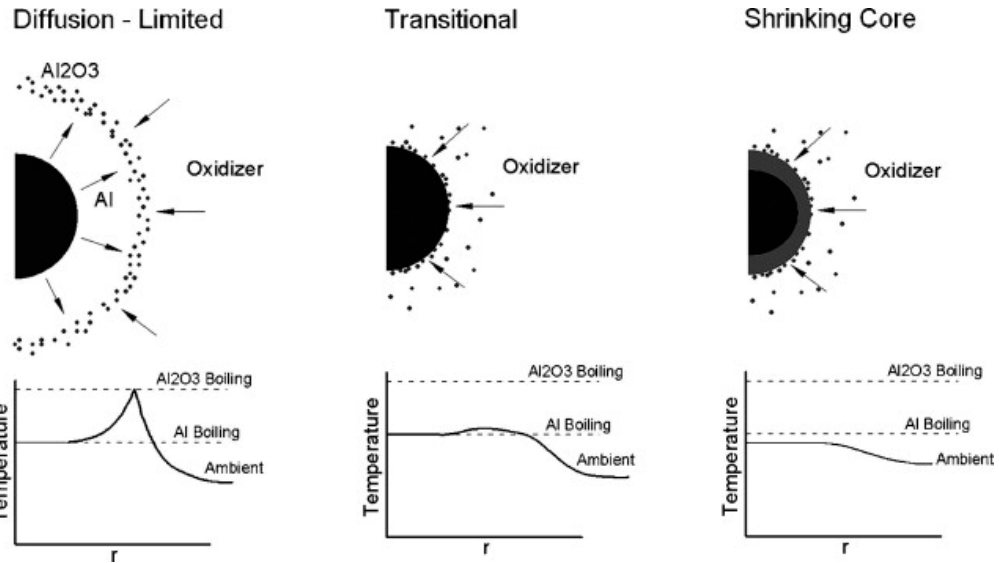
Figure 6. Schematic of the flame structures presenting in aluminum combustion. Reproduced from [19], with permission from Prog. Energy Combust. Sci., 2017.